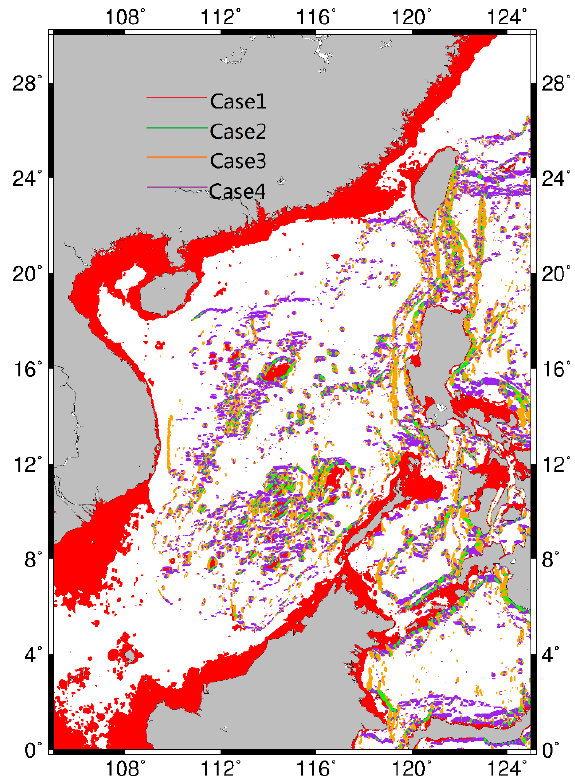
Figure 5. Distribution of grid points in different cases. Table 7. Statistics of differences between gravity models and the testing shipborne data (in mGal).